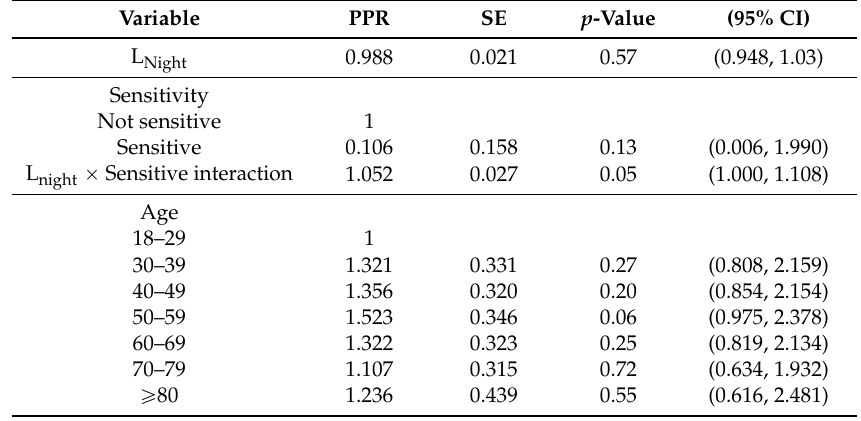
Table A10. L Night and marginal proportions of sleep disturbance by total environmental noise in the weighted study sample, adjusted for sensitivity to noise: regression